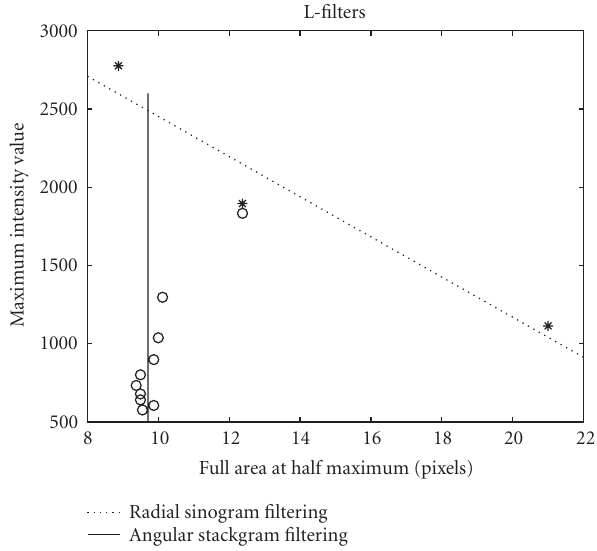
Figure 7: Maximum-intensity-value versus FAHM for the com- pared methods with the nonlinear L-filters. The data points repre- sent the di ff erent filter kernels. The filter width or length increases from top to bottom. A polynomial of the first degree was fitted for the three radial filtering data points, whereas a line was fitted for the quantified stackgram data. Most of the obtained values for radial fil- tering were omitted from the plot and from the polynomial fit, since the values did not fit the appropriate scale. The highest stackgram data value was excluded from the line fit. Angular stackgram filter- ing seems to preserve the resolution (or FAHM) almost perfectly, at the cost of decreasing maximum count